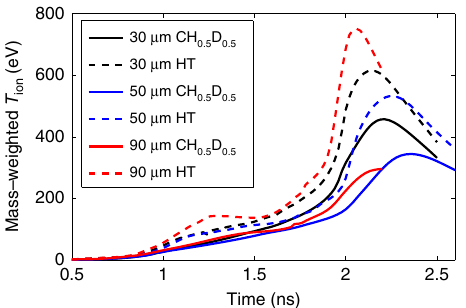
Fig. 4 Comparison of simulated species temperatures. Mass-weighted ion temperatures for each reacting material in 3D simulations with varied pore size Data is included for simulations with 30 μ m (black), 50 μ m (blue), and 90 μ m (red) pore sizes. The temperatures for the CH 0.5 D 0.5 foam matrix use solid lines and the temperatures for the HT gas fi ll use dashed lines. The HT temperatures are consistently higher than the CH 0.5 D 0.5